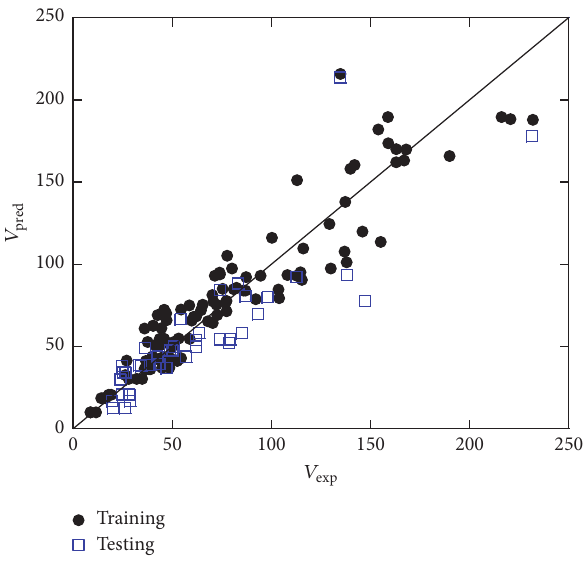
Figure 5: Training and testing of proposed model.